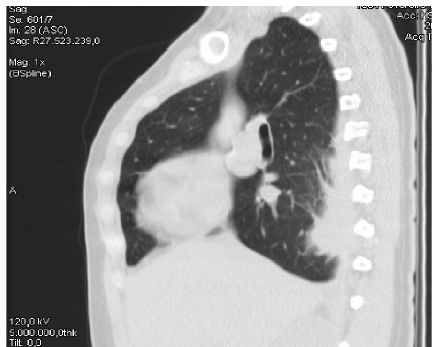
Figure 1: Chest CT with evidence of pleural right lesion.